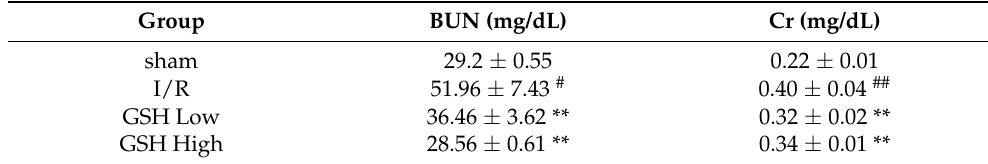
Table 2. Effect of GSH on renal functional parameters.